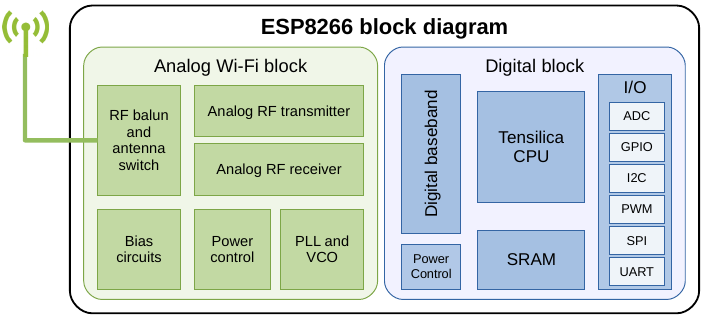
Figure 4. Block diagram of the ESP8266EX SoC.